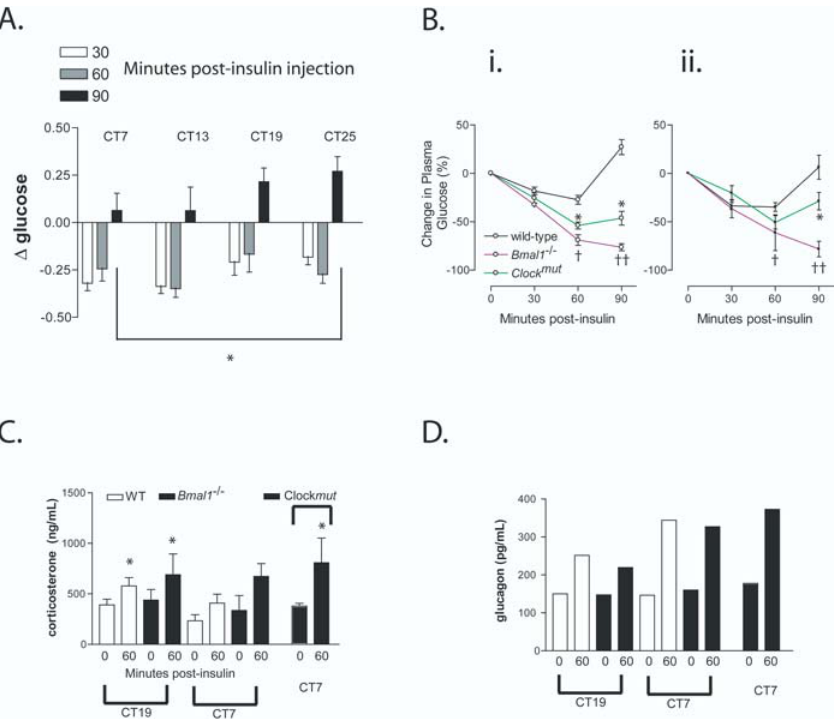
Figure 2. Disruption of Genes in the Core Molecular Clock Alters the Response to Insulin (A) Insulin tolerance (IT) was examined in WT mice on CT7, CT13, CT19, and CT25 at 30 min, 60 min, and 90 min after insulin injection ( n ¼ 12 per time point, * p , 0.01). (B) IT was examined in WT (black line), Bmal1 (cid:1) / (cid:1) (blue line), and Clock mut mice (green line) at CT1 (i) and CT13 (ii) ( n ¼ 6–10, * p , 0.05, (cid:1) p , 0.01, (cid:1)(cid:1) p , 0.001). (C and D) Plasma levels of the counter- regulatory hormones corticosterone (C) and glucagon (D) were assessed 60